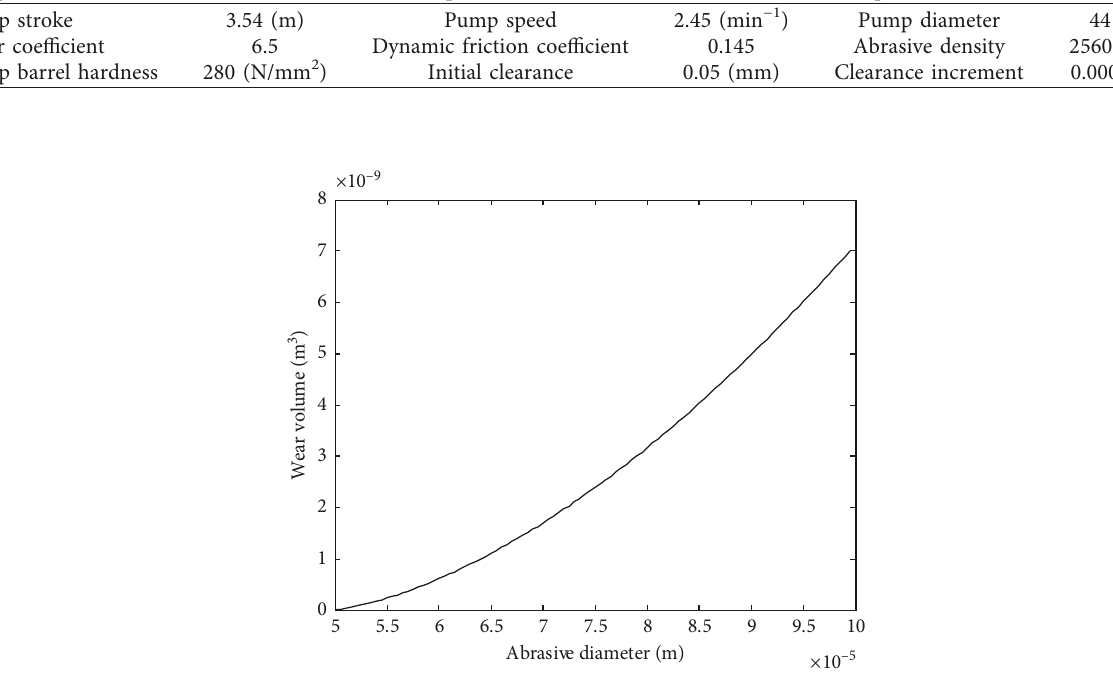
Figure 8: Wear volume change curve.